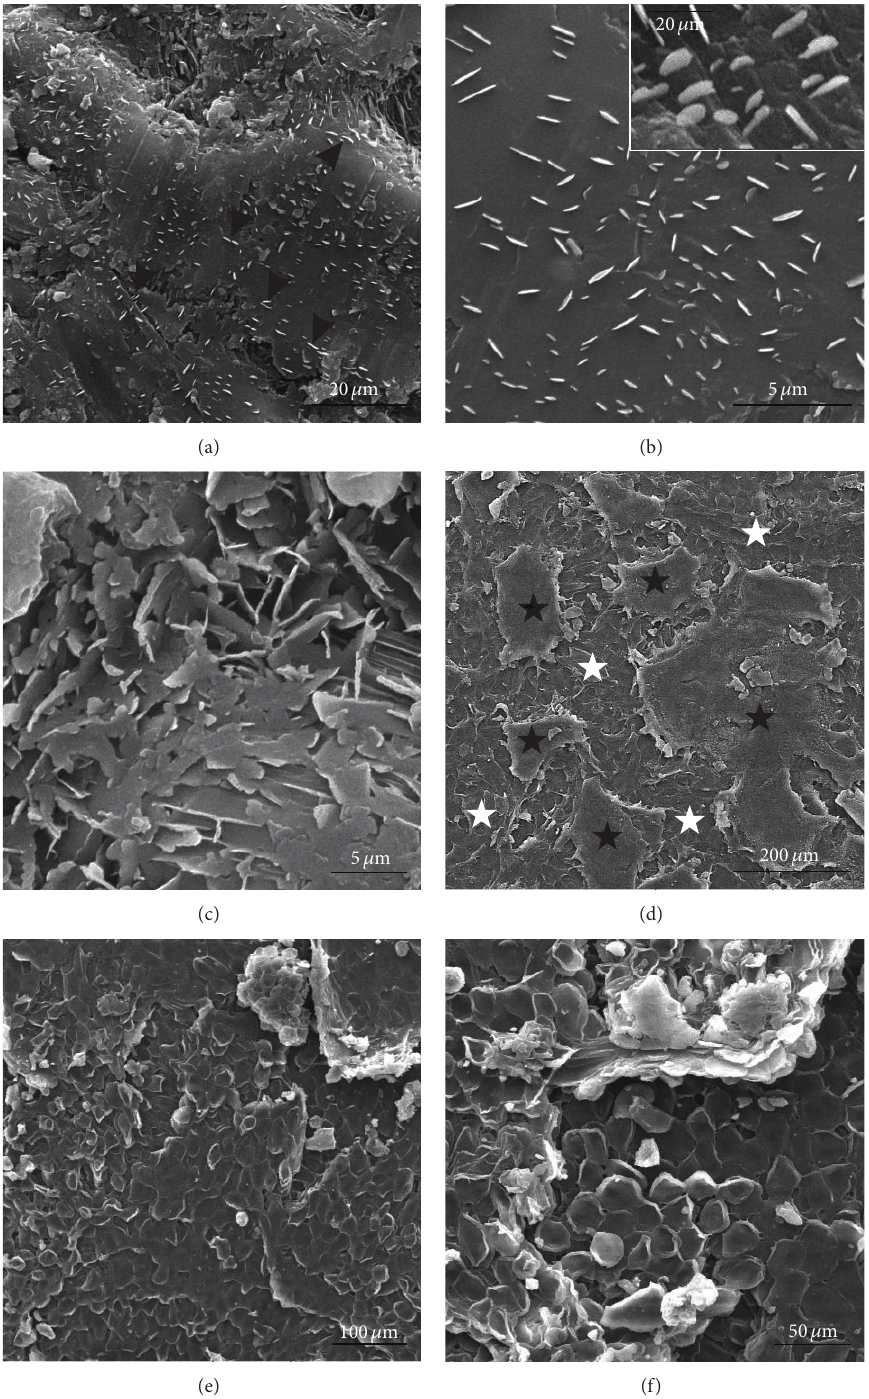
Figure 4: SEM: epidermis surface of the “Conference” fruits at the harvest maturity stage. ((a), (b)) vertical wax platelets on the epidermis surface (arrowheads); (c) vertical and horizontal platelets of the epicuticular wax inside a microcrack; (d) fruit surface with remains of the epidermis (black asterisk) and russeting formed by cork cells (white asterisk); polygonal cork cells were visible within the lenticels (e) and microcracks (f). Note the lack of crystalline wax